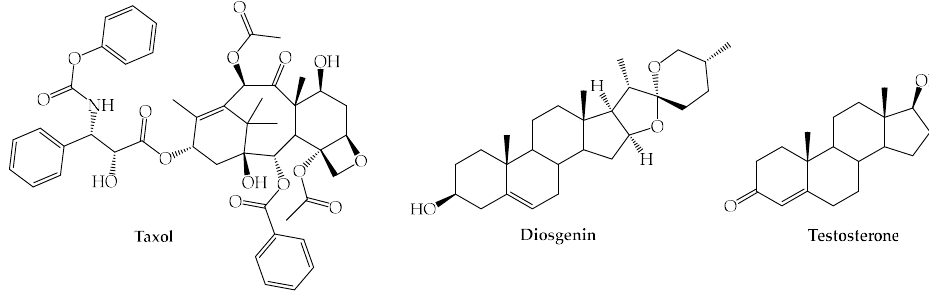
Figure 1. Structures of Taxol, Diosgenin, and Testosterone.